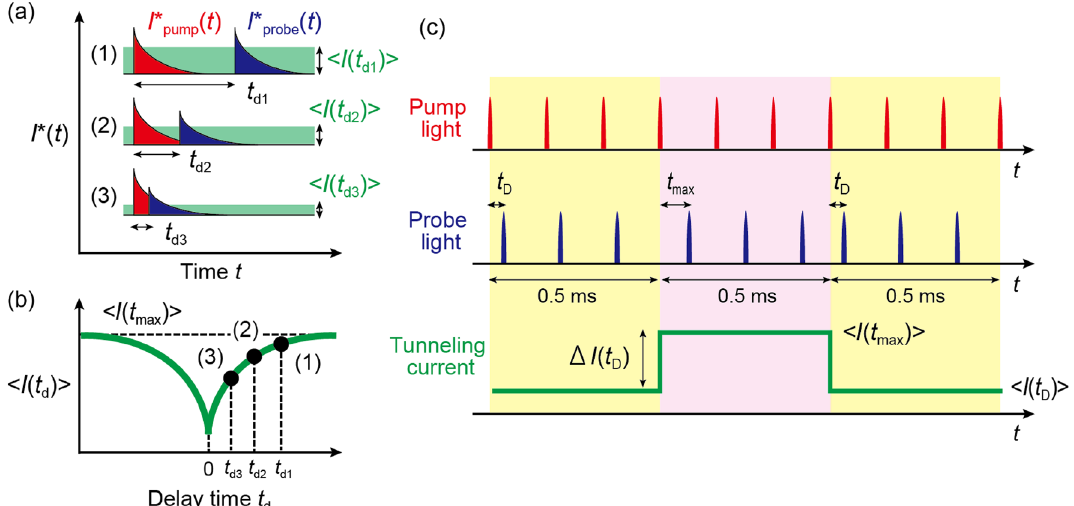
Figure 4. ( a ) Relationship between transient tunneling current I ∗ induced by the pump and probe light and delay time t d . Time-averaged tunneling current < I > is shown for each case. ( b ) < I > as a function of t d . The time-averaged < I > corresponding to each case in ( a ) is plotted with corresponding number. ( c ) Schematic of the delay-time modulation technique. The delay time between the pump and probe pulses is modulated between t D and t max at ∼ 1 kHz. Consequently, < I > is also modulated between < I ( t D ) > and < I ( t max ) > at ∼ 1 kHz, and the lock-in amplifier detects � I ( t D ) = < I ( t D ) > − < I ( t max ) >